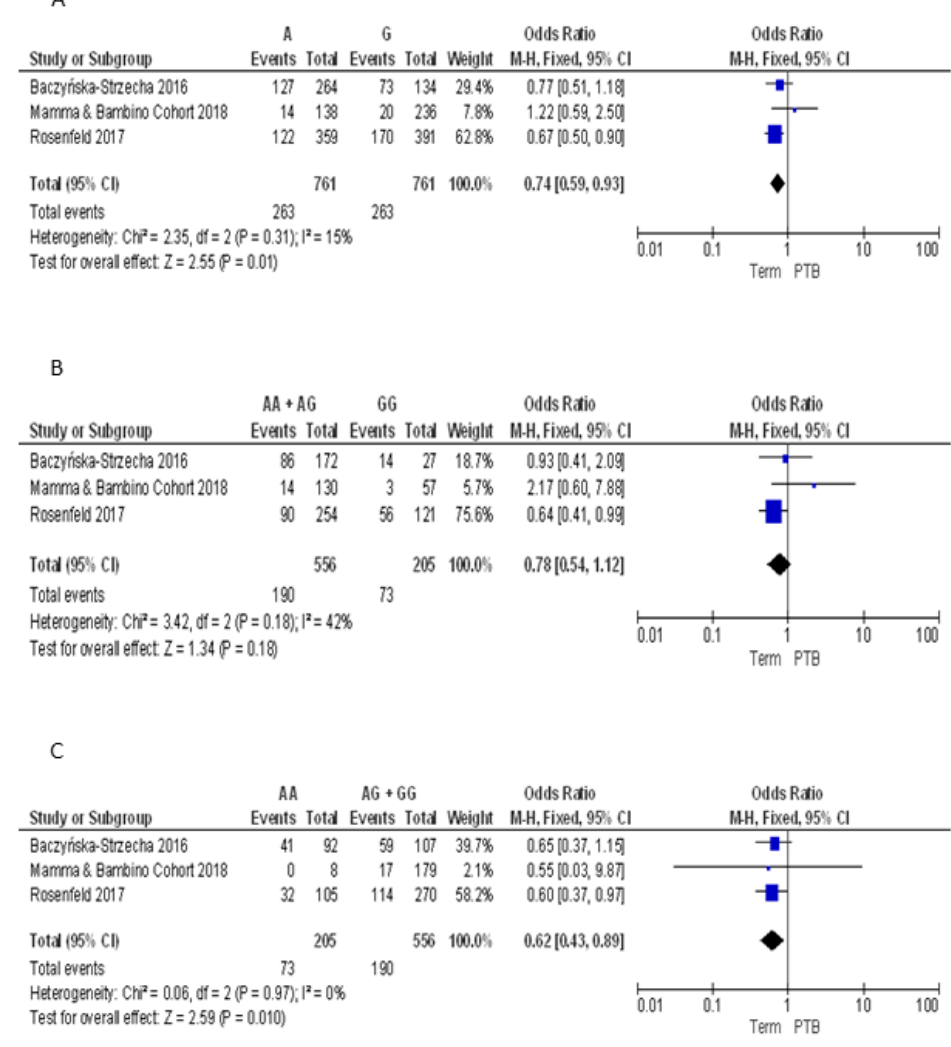
Figure 4. Forest plots of the association between BsmI polymorphism and preterm birth under the ( A ) allelic, ( B ) dominant and ( C ) recessive models.